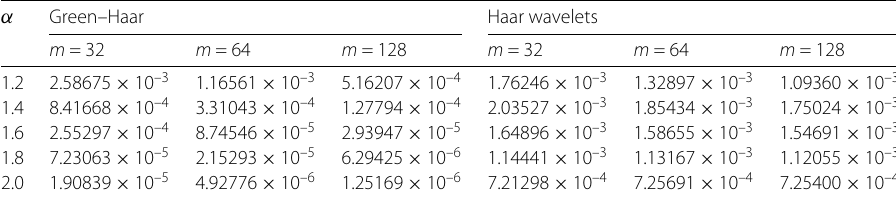
Table 6 Maximum absolute error for ρ = 1.5 and different values of m , α α Green–Haar Haar